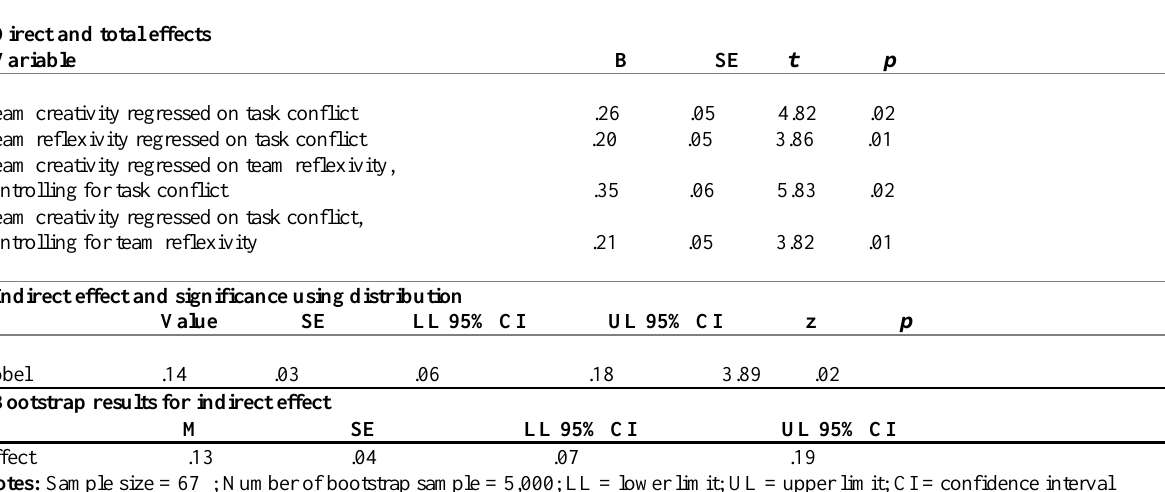
Table 3: Regression results for